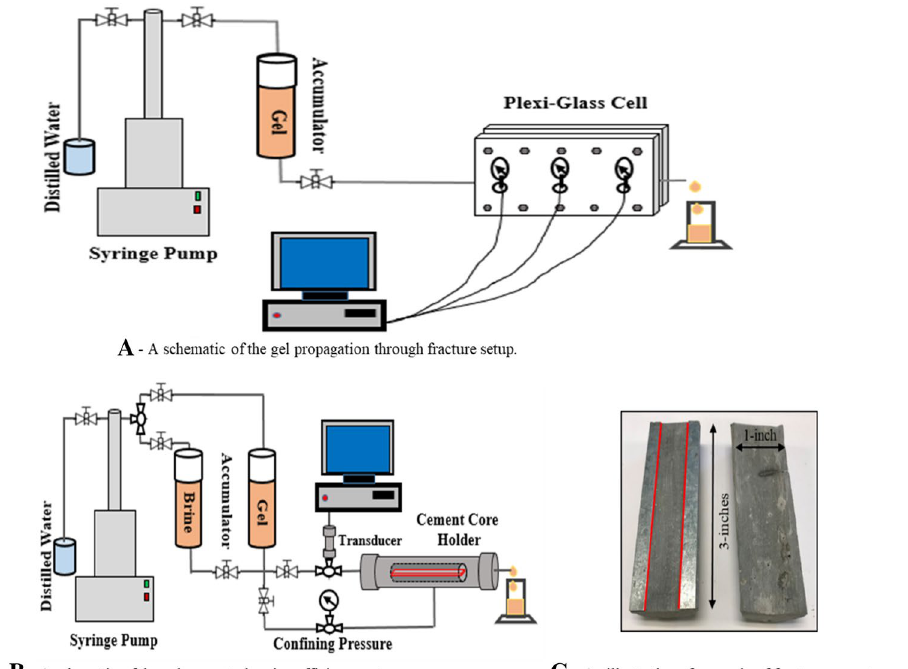
Fig. 1 An illustration of the setups used in this study and a sample of fractured cement